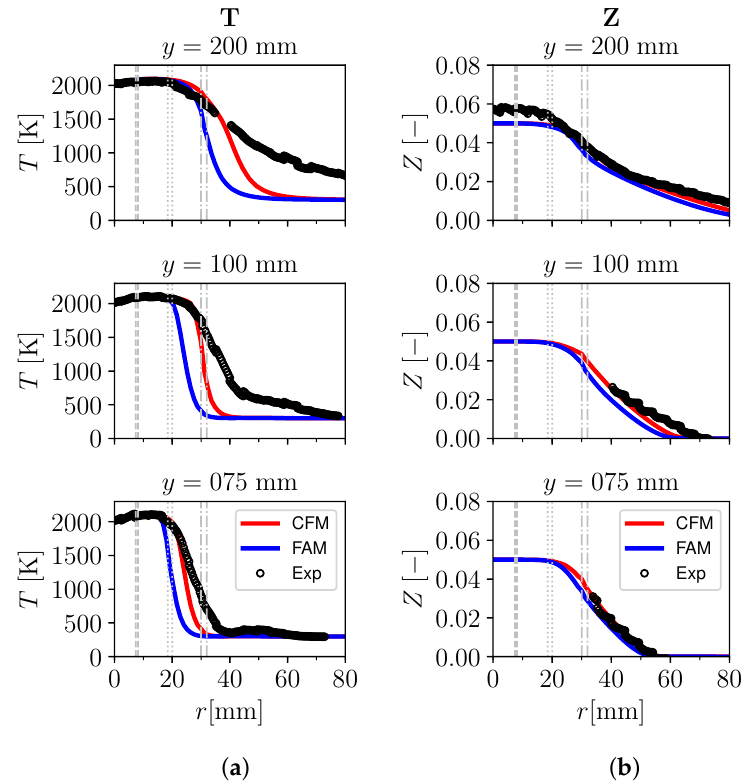
Figure 11. Case A-r: radial profiles of mean temperature T ( a ); and mean mixture fraction Z ( b ); computed with different models at axial positions 75 mm experimental